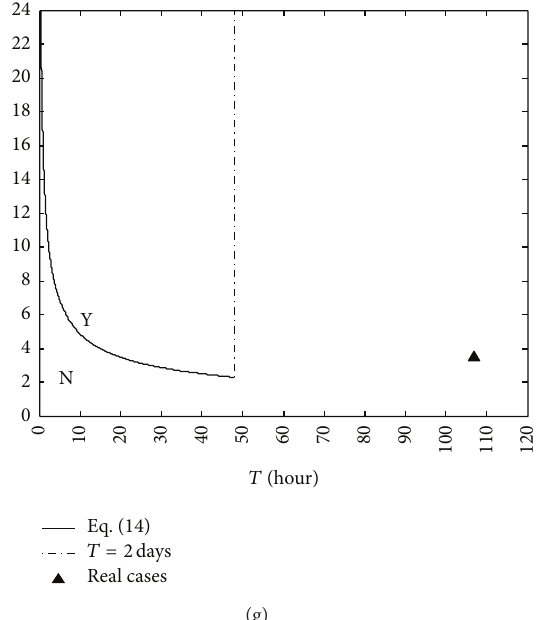
Figure 4: Comparison of the model with real cases of Aoshio observed from 1978 to 2002 in a particular month. (a) May, (b) June, (c) July, (d) August, (e) September, (f) October, and (g)